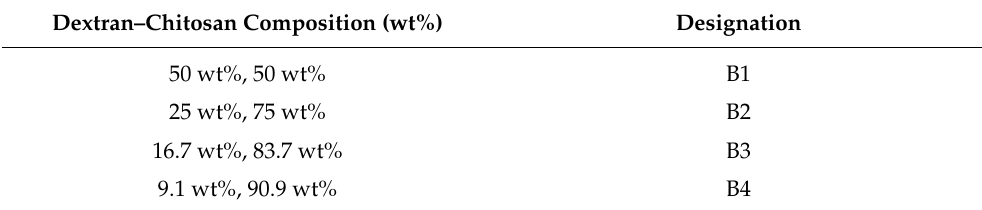
Table 1. Designation for dextran–chitosan nanocomposite